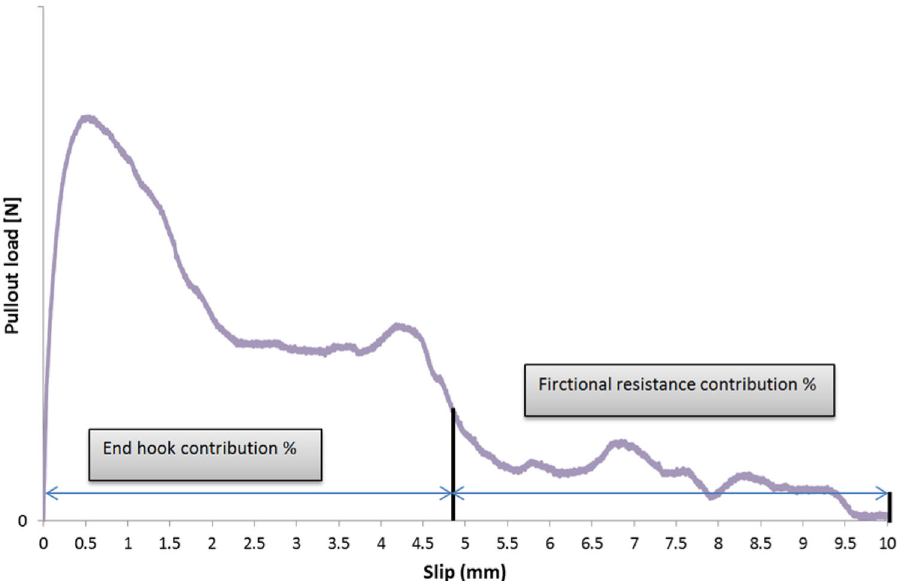
Fig. 11 Example showing the contribution of the end hooks component and frictional resistance to the overall pullout behaviour of 3DH2 fibres.